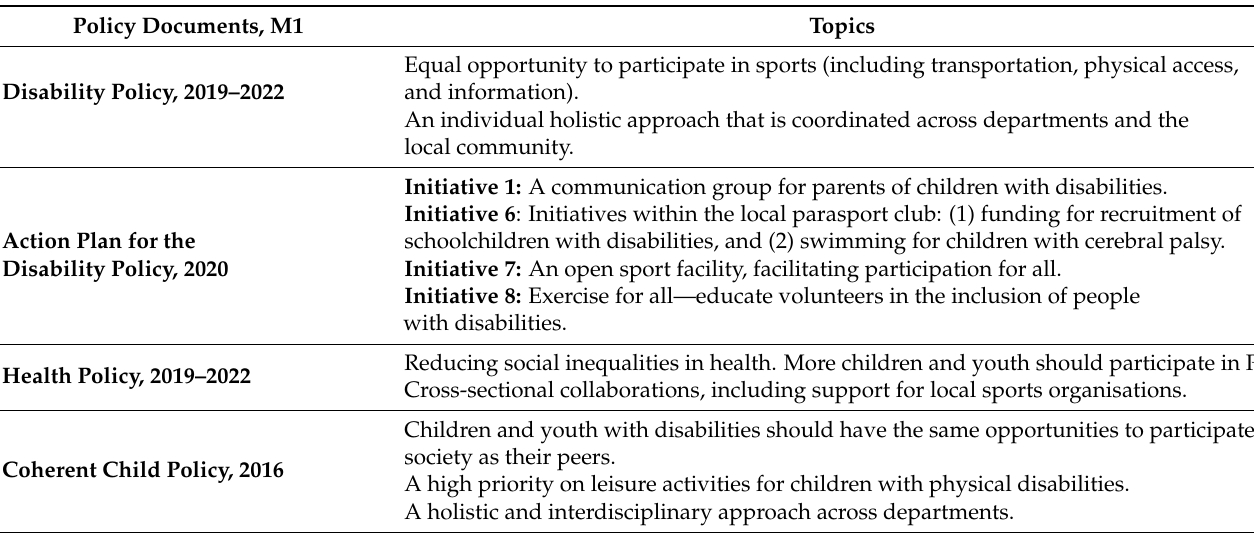
Table 3. Policy documents, Municipality 1